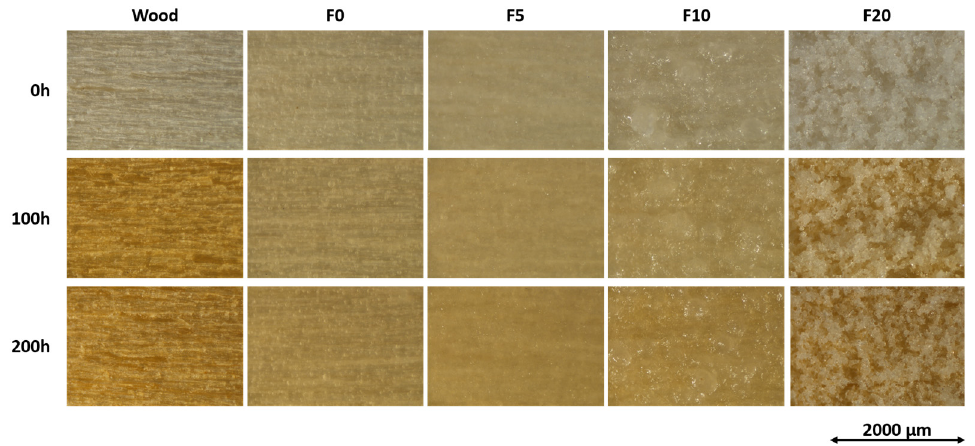
Figure 4. Change in the appearance of the coated samples and the wooden reference panel during exposure to UV-B radiation.